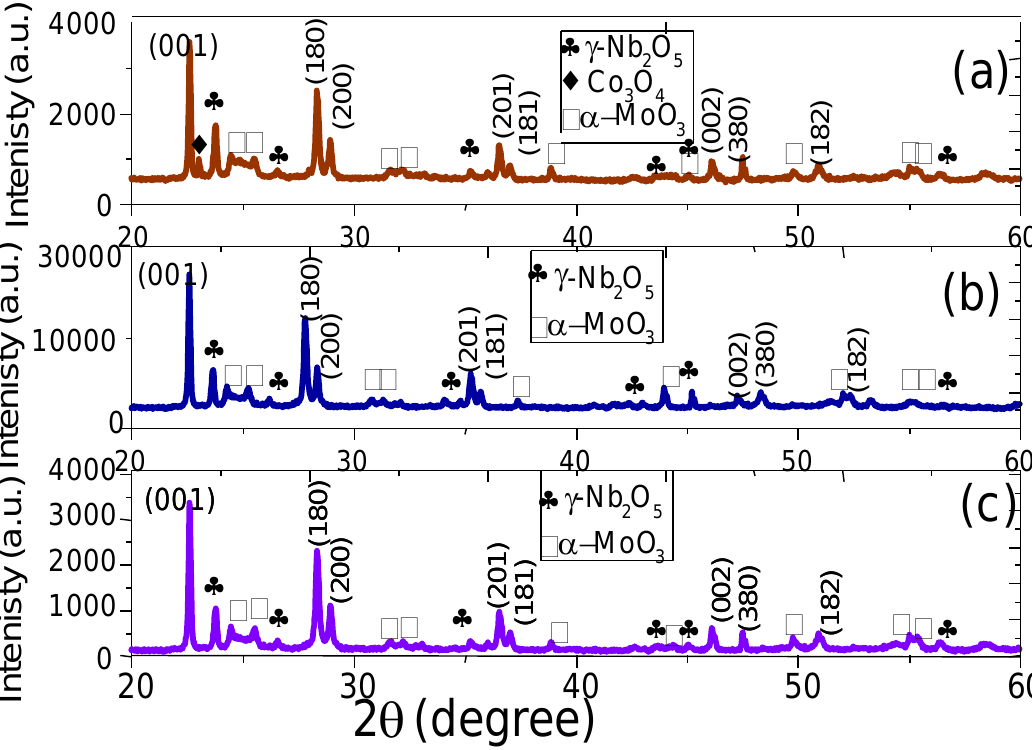
Figure 1. XRD patterns of the catalysts: ( a ) CoMo/Nb 2 O 5 , ( b ) NiMo/Nb 2 O 5 and ( c ) PtMo/Nb 2 O 5. Other diffraction peaks appearing at 2θ values of 23.8, 26.7, 35.2, 43.6, 45.1 and 56.4° are indexed as (001), (100), (101), (002), (110) and (182), respectively. These reflections are associated with the